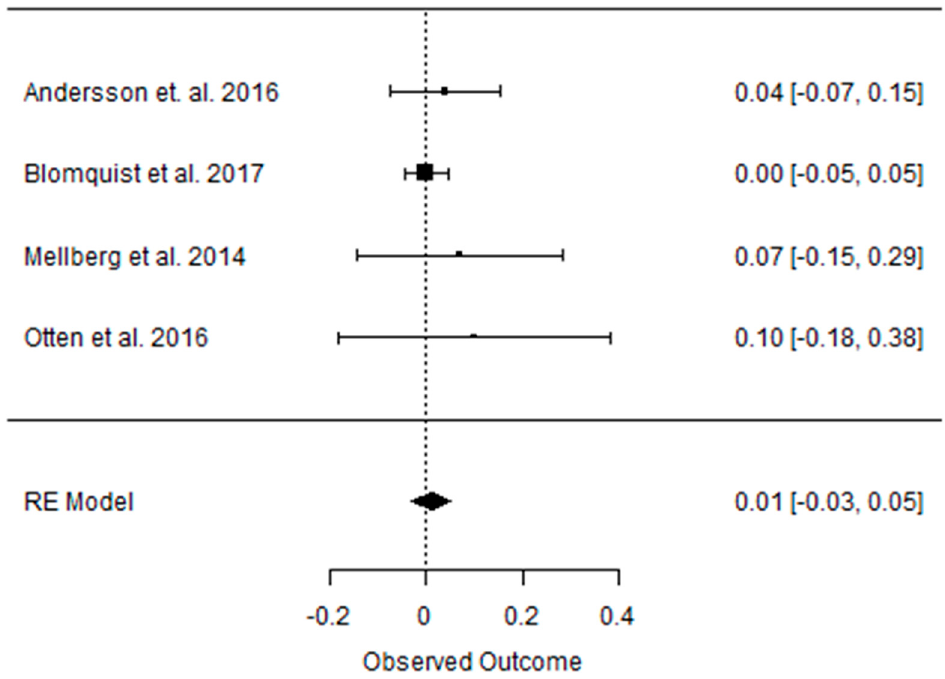
Figure A27. Forest plot of the effect of a CD on TC in the long term (weighted mean difference).